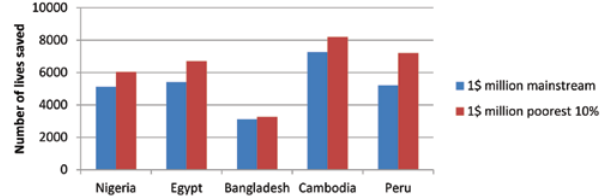
Figure 12 Estimated number of lives saved in Mainstream vs Eq- uity–promoting models for the same investment.